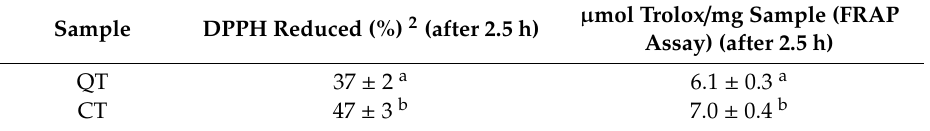
Table 2. Antioxidant properties of CT and QT. 1